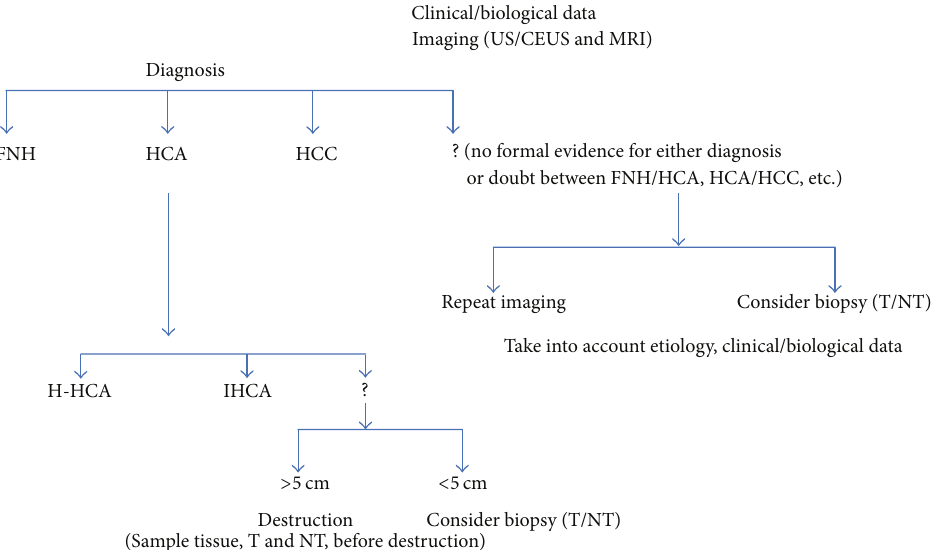
Figure 2: Practical guidelines for the identification of HCA subtypes (outside the emergency context).